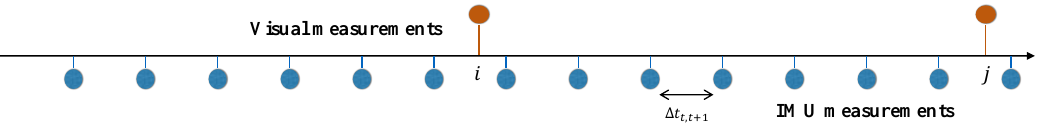
Figure 4. IMU sensor measurements are typically much faster than the camera frame rate. The EuRoC benchmark provides the IMU sensor readings at 200 Hz and camera images at 20 fps. i and j denote the time of camera capture, and t is the IMU measurement